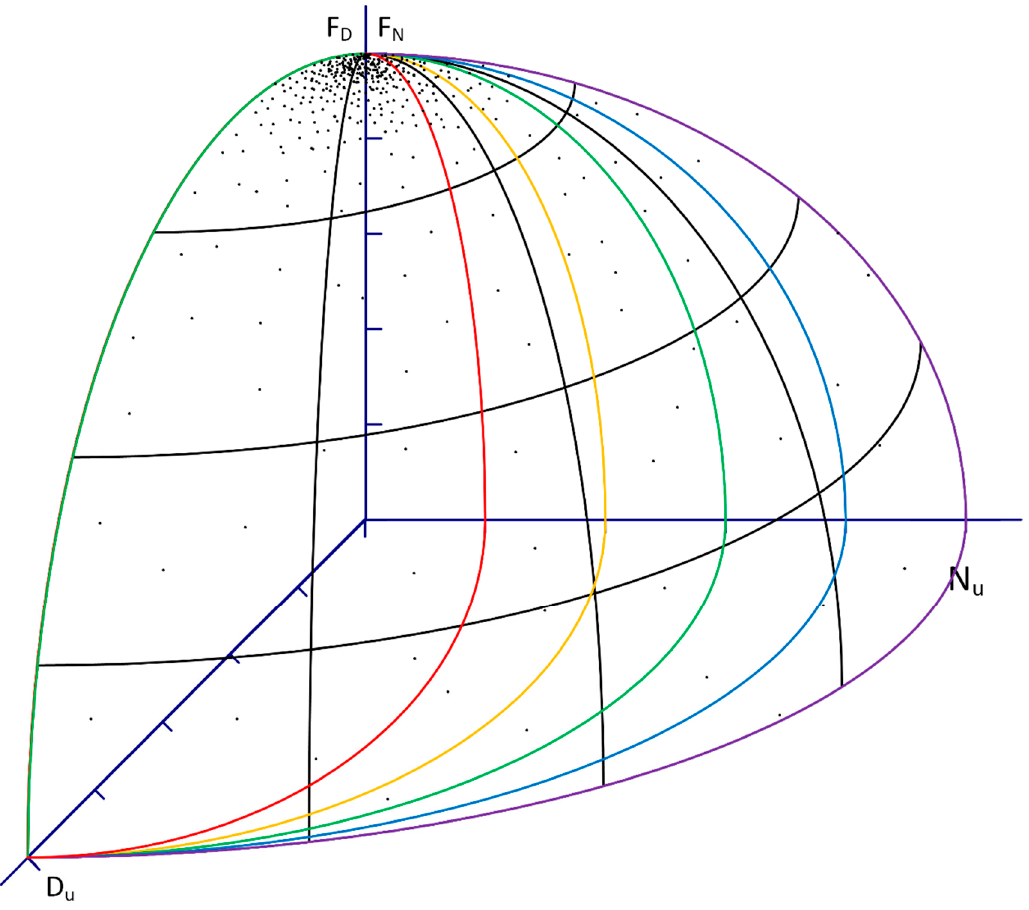
Figure 1. Stochastic sampling from within the possibility space .